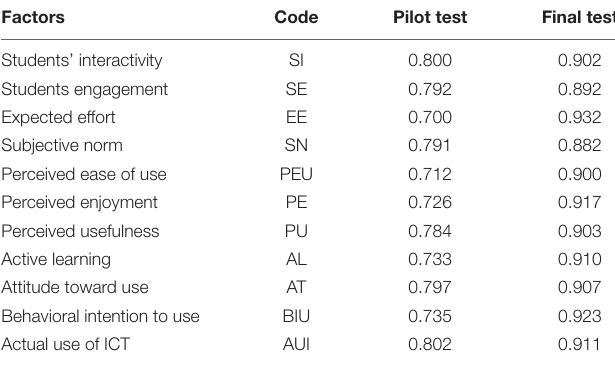
TABLE 2 | The reliability coefficient for all